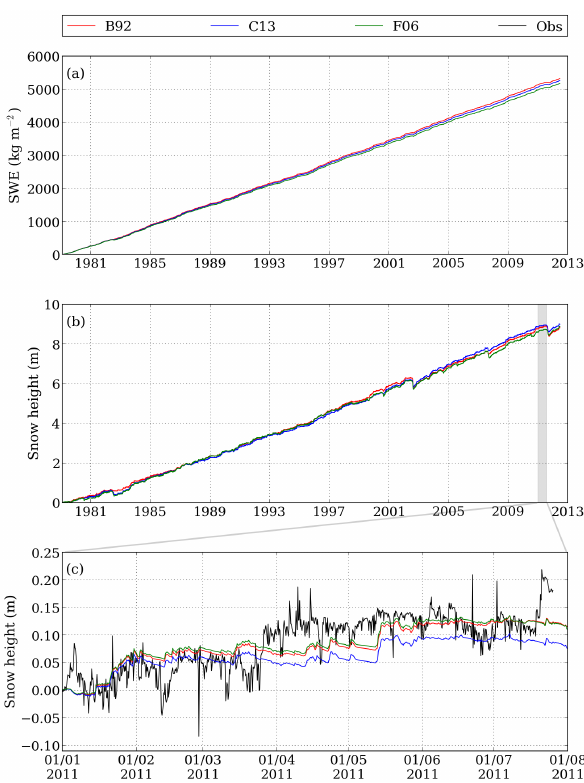
Fig. 5. Time evolution of SWE and snow height at Summit. The metamorphism formulations described in Sect. 2.3 are represented by different colours: B92 (Brun et al., 1992) in red, C13 (this work) in blue and F06 (Flanner and Zender, 2006) in green. Observations from AWS are in solid black. (a) Simulated SWE since 1 February 1979. (b) Simulated snow height since 1 February 1979. (c) Close up on simulated and measured snow height during our field campaign (all curves are reset to zero on 1 January 2011, in order to better compare them).